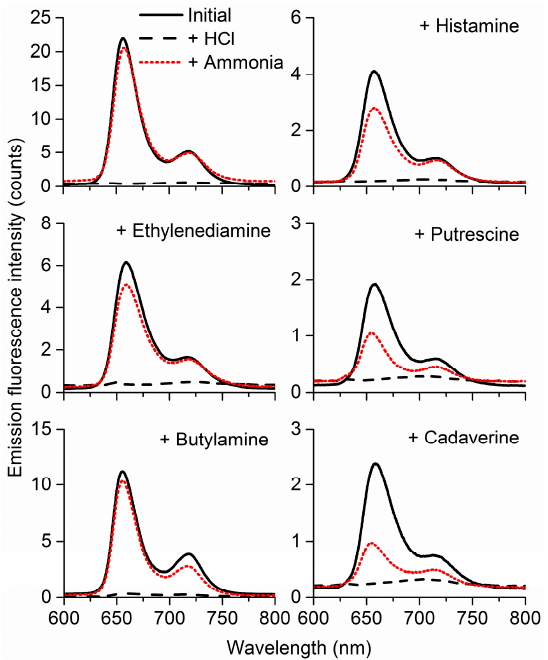
Figure 6. MMPyP/TiO 2 spectra before any exposure (solid black line), after protonation with HCl gas (dashed black line), and after exposure of its protonated form to ammonia and amine vapours (dotted red line).